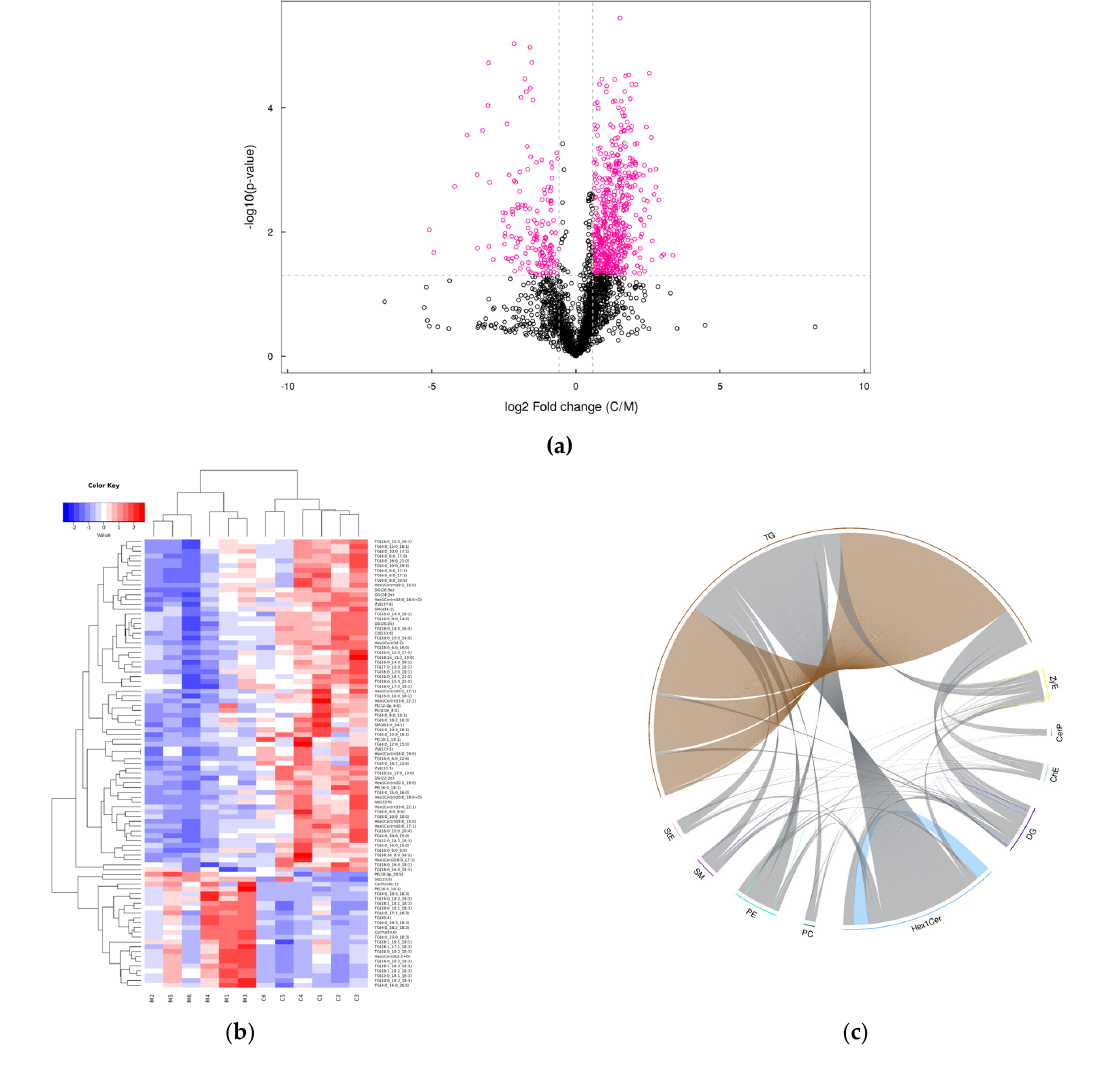
Figure 3. ( a ) Volcano plot of the lipids abundance in yak colostrum by contrast with mature milk. The abscissa represent the value of log 2 fold change (FC), and the ordinate represent the value of − log 10 p . A point represents a lipid molecule. The points with FC > 1.5 or < 0.67, p < 0.05 are shown with red, and non-signi fi cantly di ff erent lipids (SDLs) are shown with black. ( b ) Cluster heat map of SDLs. Each row represents a SDL, and each column represents a samples. The color blocks at di ff erent positions represent the abundance of lipid molecules. Red represented a high abundance, and blue represented a low abundance. ( c ) Chord diagram of lipid subclasses. The starting point of link in the inner circle represented the SDL, and the arc on the outer circle represents the lipid subclasses. The colored lines indicate the correlations of lipid molecules within the subclass, and the lines are the same color as the subclass. The dark gray lines indicate the correlations between the subclasses.